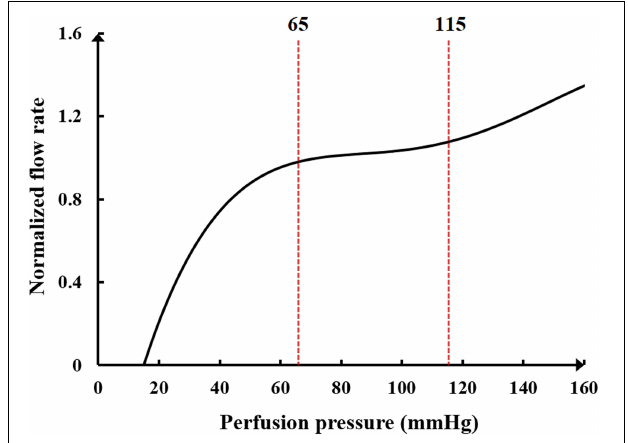
FIGURE 3 | The relationship between normalized blood flow and perfusion pressure in the coronary flow